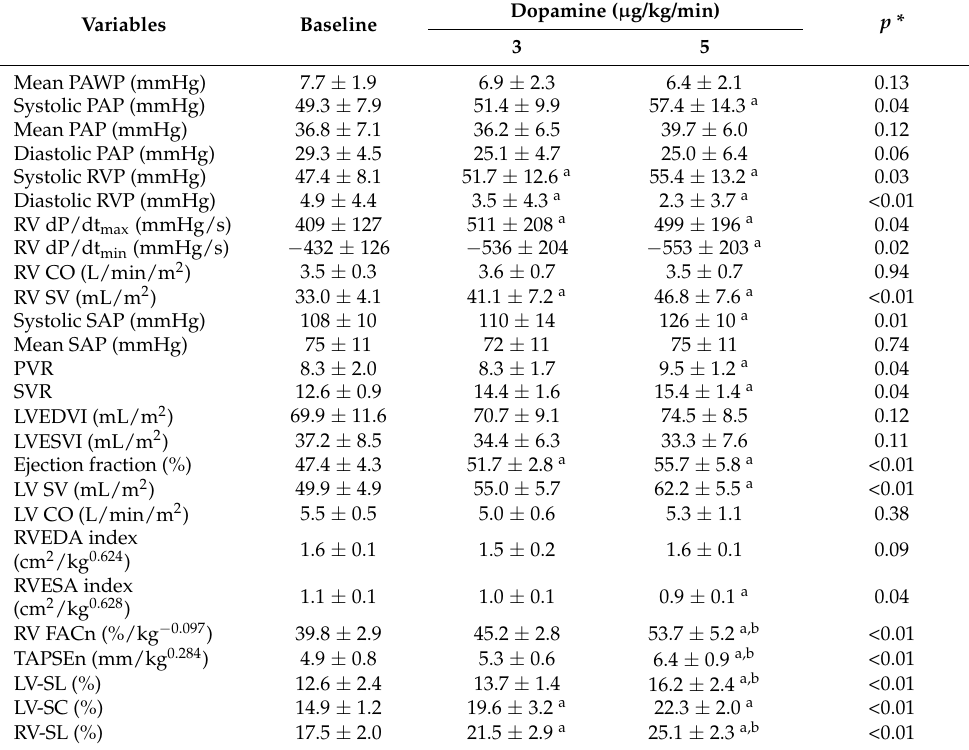
Table 3. Results of hemodynamic and echocardiographic variables before and after dopamine